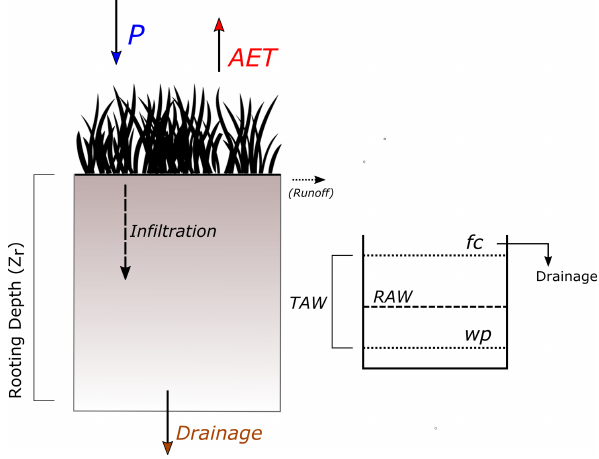
Figure 3. Simple conceptual design of a homogenous soil column with incoming and outgoing fluxes and relevant soil parameters defining the amount of available